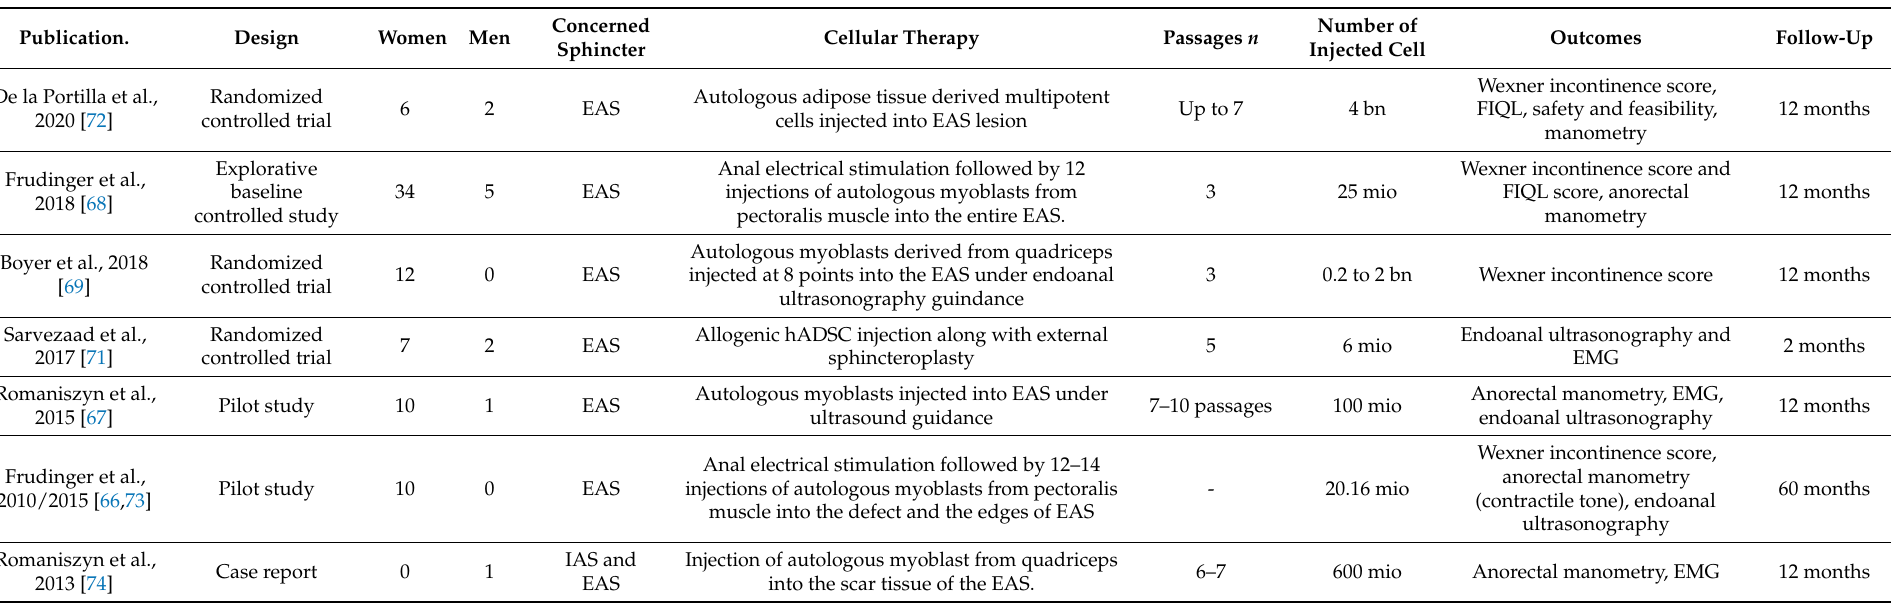
Table 2. List of clinical studies on cell therapy for anal incontinence treatments. bn: billion, mio: million, FIQL: Fecal Incontinence Quality of